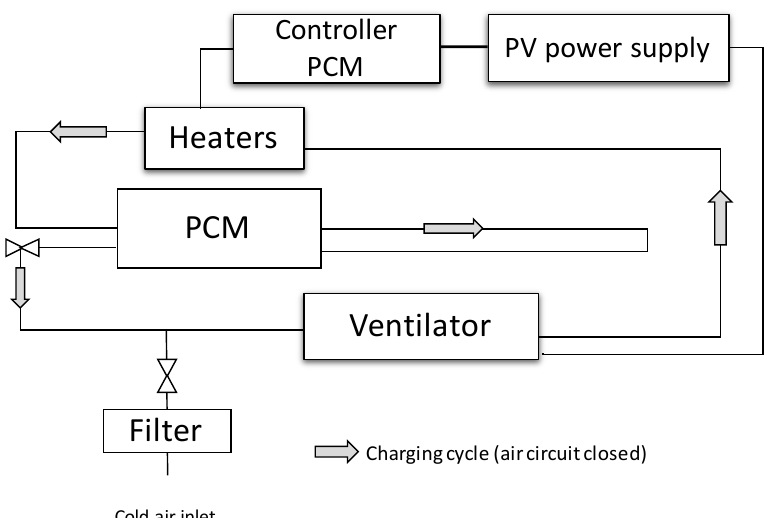
Figure 4. PCM battery charging diagram in a closed circuit .